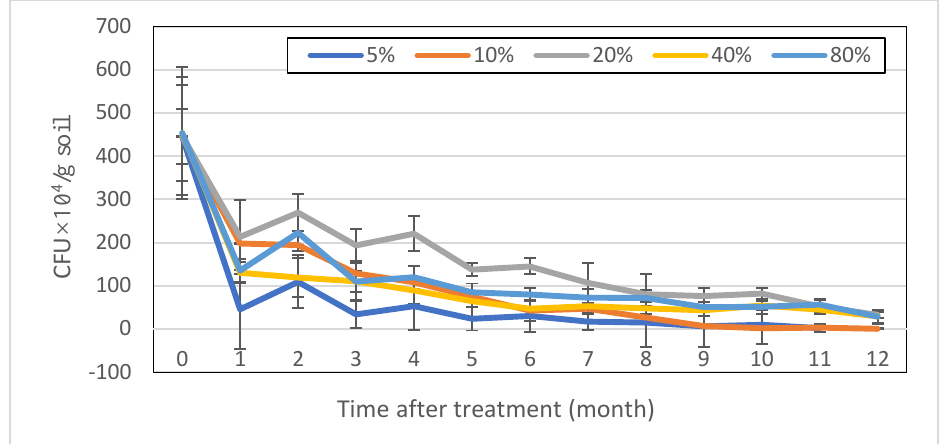
Figure 2. Survival dynamics of Trichoderma longibrachiatum Tr58 conidia in soils with different moisture contents.